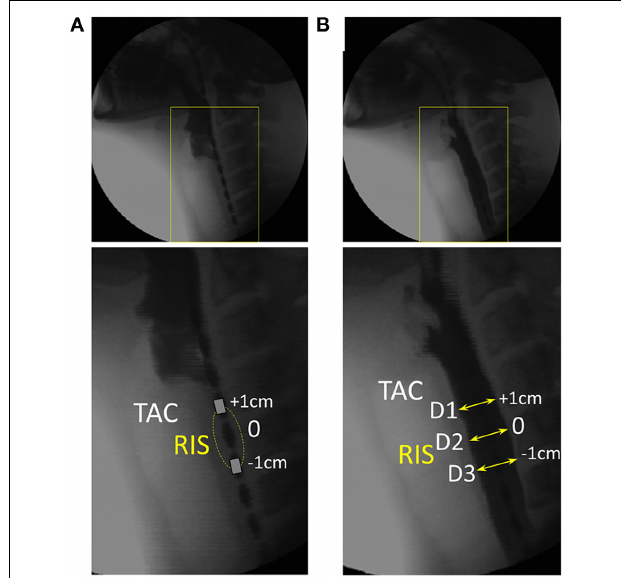
FIGURE 3 | Videofluoroscopy images showing how luminal diameter was precisely measured over time. For this example 10ml liquid swallow the approximate position of the UES is identified through visualization of the tracheal air column (TAC). (A) Image immediately preceding UES penetration by liquid contrast. The most optimally located reference impedance segment (RIS) is adjacent to the TAC. (B) Image showing the barium column at maximum diameter and surrounding the RIS. Diameter was measured at the axial center (D2) and at both the proximal and distal ring electrodes (D1, D3) demarcating the margins of the reference impedance segment. Sequential measurements were performed from entry to exit of all of the barium within the